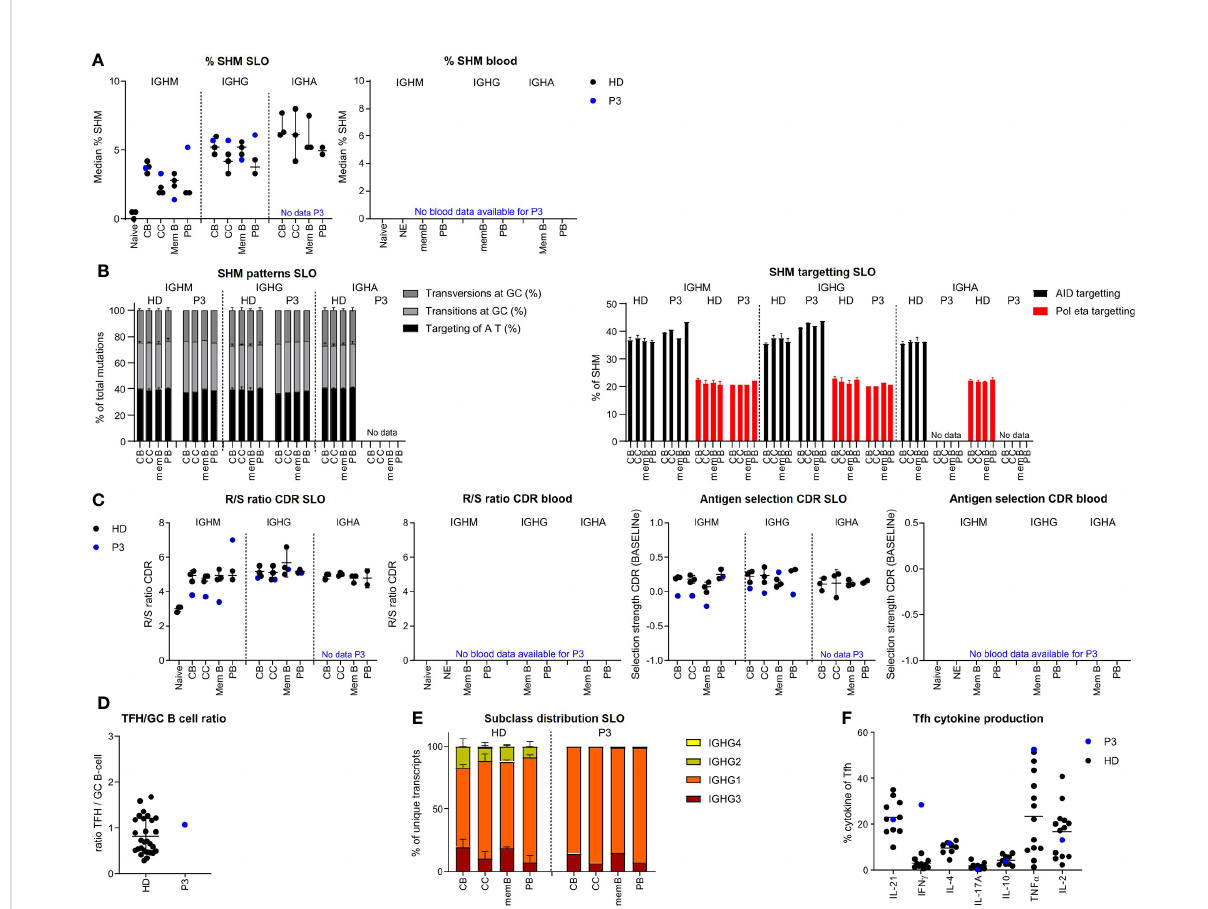
FIGURE 4 BCR repertoire analysis reveals increased SHM, impaired antigen selection, and altered subclass distribution in P3. (A) Median percentage of SHM in BCR transcripts of sorted B-cell populations. (B) SHM patterns and targeting in sorted B-cell populations. (C) Evaluation of antigen selection in sorted B-cell populations. (D) Tfh/B-cell ratio in the lymph node. (E) Subclass distribution in IGHG transcripts of sorted lymph node populations. (F) Cytokine production of Tfh